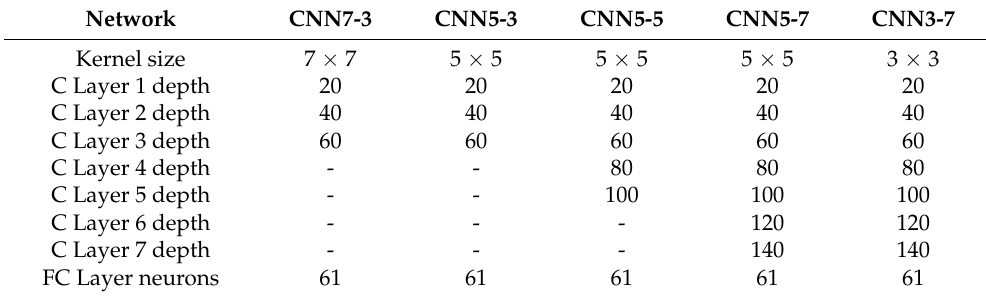
Table 3. Kernel size, filter depth and neurons of DCNN